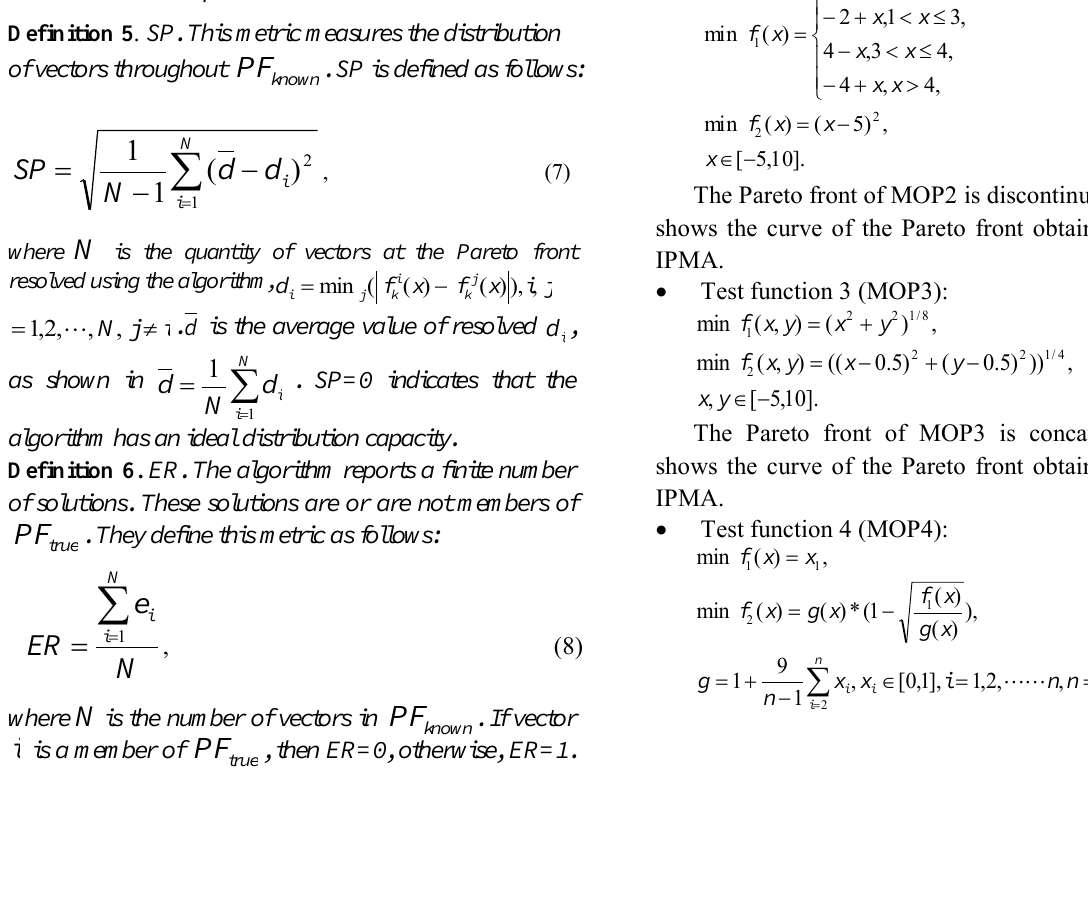
The Pareto front of MOP3 is concave. Figure 3 shows the curve of the Pareto front obtained using the